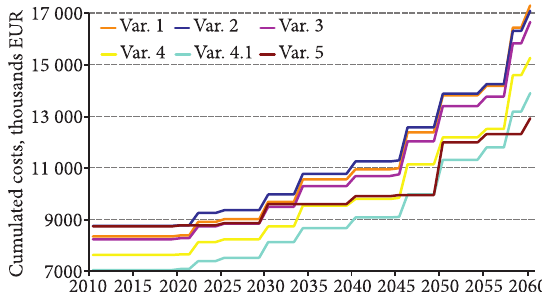
Fig. 12. Graph – the course of cumulated costs (thousands EUR) of all variants for the period of 50 years (the price index of 3%)